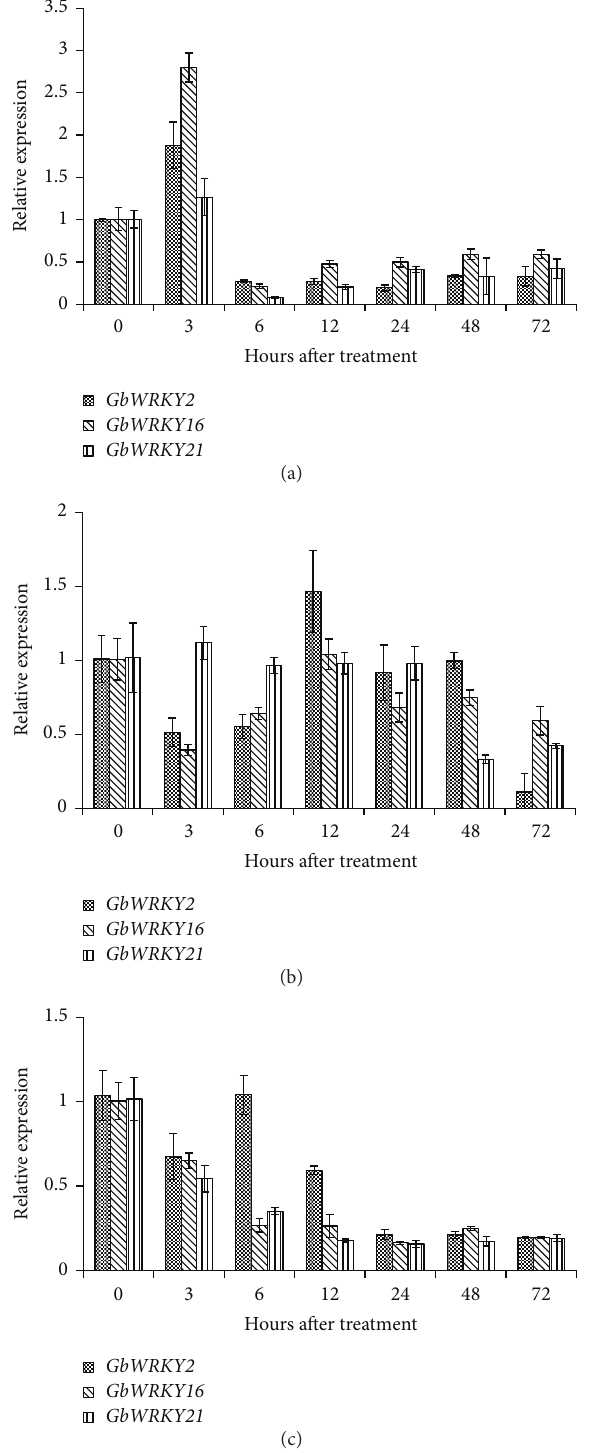
Figure 2: Relative expression levels of GbWRKY2 , GbWRKY16 , and GbWRKY21 under salinity (a), cold (b), and heat (c) treatments. Relative expression of GbWRKY2 , GbWRKY16 , and GbWRKY21 at various hours after treatment under salinity, cold, and heat treatments with GbGAPDH gene as internal reference gene. Each sample was individually assayed in triplicate. Values shown repre- sent the mean reading from three treated samples and the error bars indicated the standard errors of the